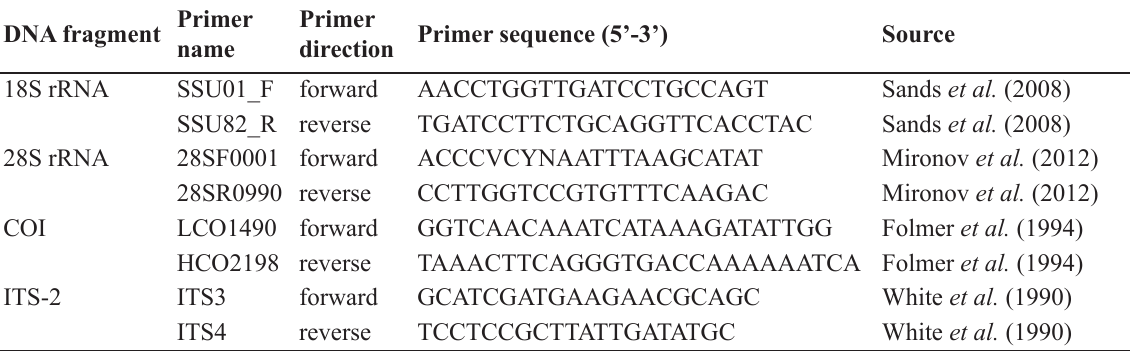
Table 1 . Primers used for sequencing of four DNA fragments (one mitochondrial and three nuclear) of Macrobiotus polypiformis sp.